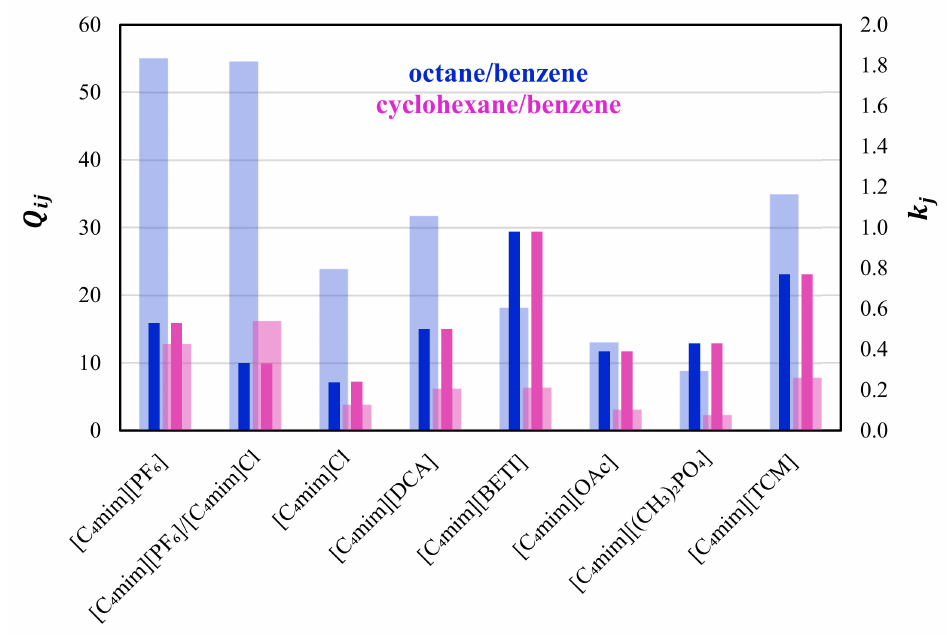
Figure 4. Comparison between the solvent performance index, Q ∞ pacities, k ∞ , (dark colored bars) at infinite dilution for the separation of octane/benzene (purple) j and cyclohexane/benzene (pink) at 333.2 K in [C 4 mim][PF 6 ], equimolar [C 4 mim][PF 6 ]/[C 4